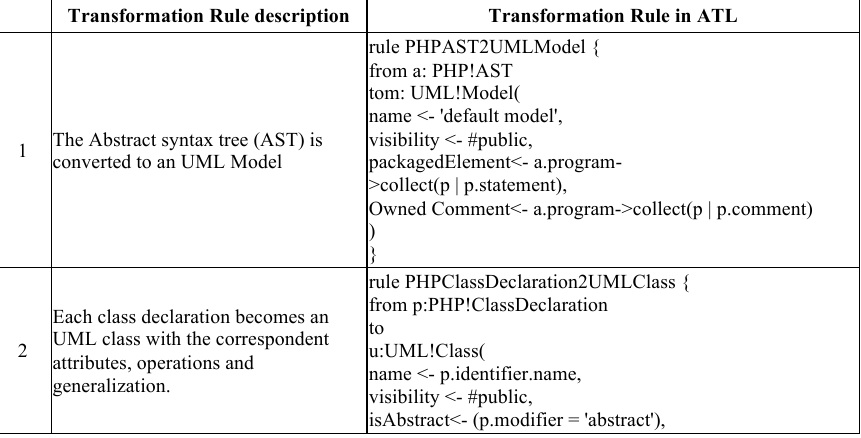
Table 2. Set of the ATL-based transformations Transformation Rule description Transformation Rule in